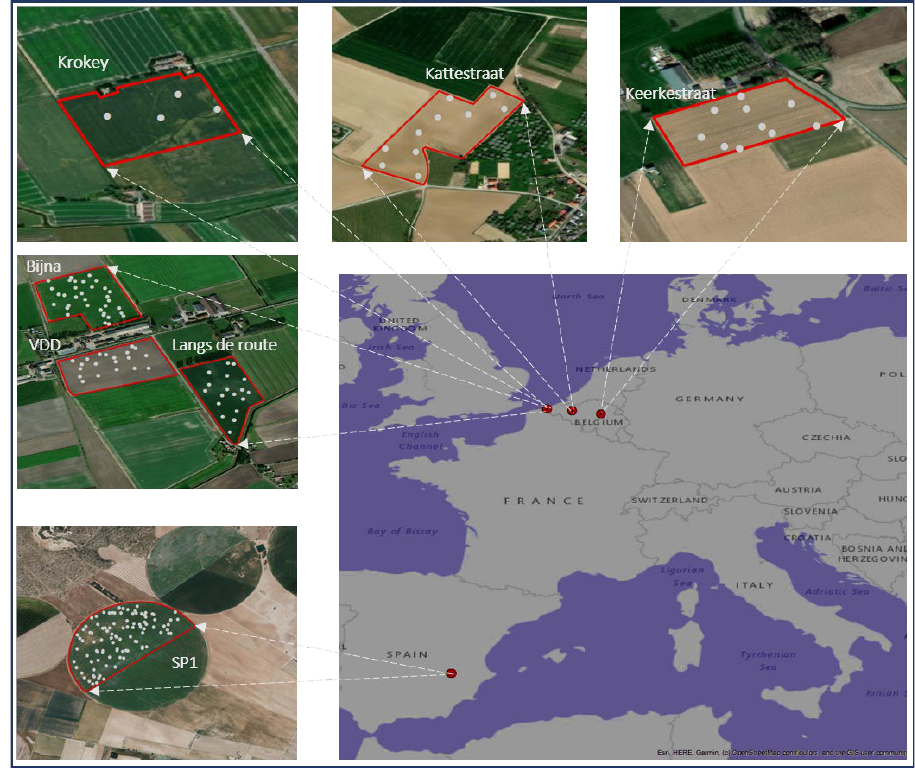
Figure 1. Location of seven experiment fields with sampling points in Belgium and Spain (described in Table 1).